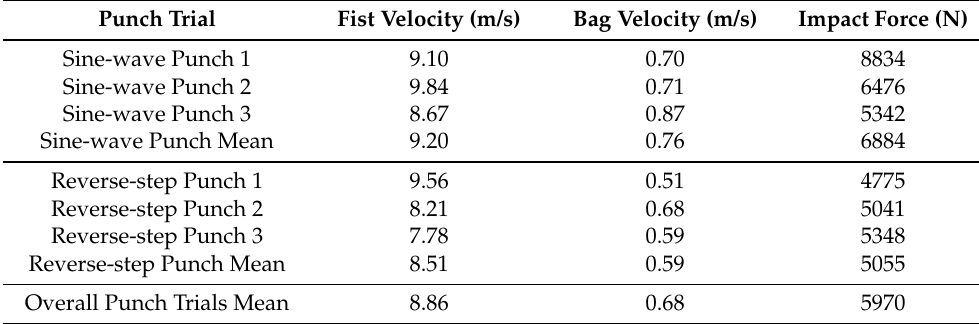
Table 2. Velocity results for Sine-wave punch and Reverse-step punch trials.